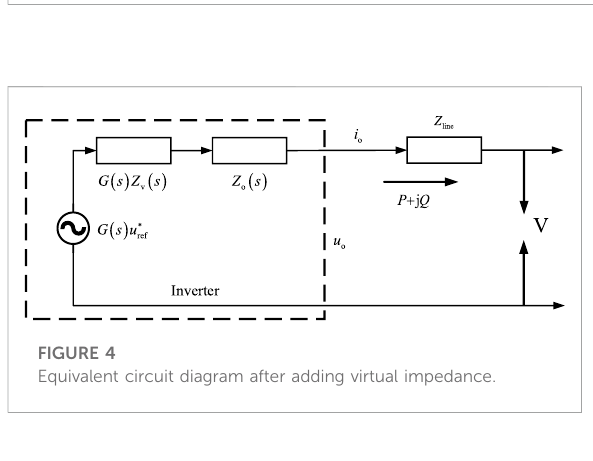
FIGURE 5 Controller structure with virtual impedance